Question: Express in one sentence what the figure is showing.
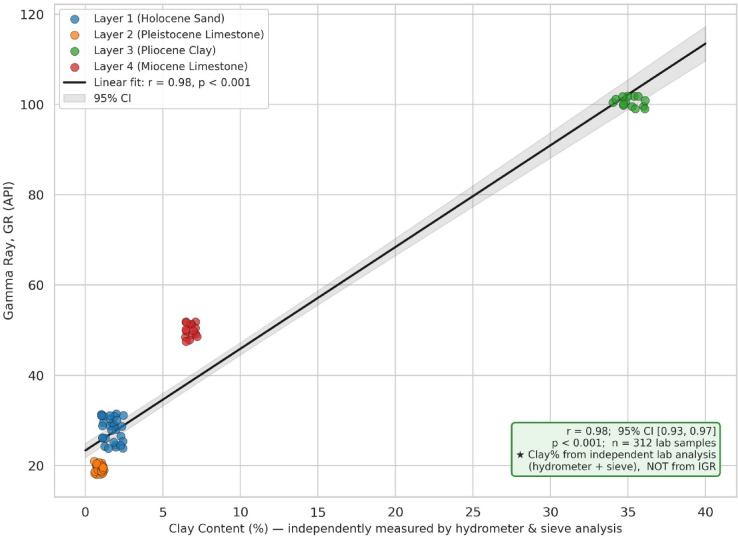
Answer: Relationship between natural gamma ray response (GR, API) and clay content (%) for all four geoelectrical layers ( n = 87 borehole–ERT stations; Ras El-Hekma). Clay content values on the x-axis were determined exclusively by independent laboratory granulometric analysis (hydrometer and sieve methods; n = 312 samples) and were not back-calculated from the gamma ray index (IGR); this independence confirms that the correlation is not tautological. Each data point is colour-coded by layer. The black line shows the ordinary least-squares regression fit across all data, with the 95% confidence interval shown as a grey-shaded band. The strong positive correlation ( r = 0.95; 95% CI: [0.93, 0.97]; p < 0.001) is particularly evident in Layer 3 (Pliocene Clay), where GR values exceed 99 API at clay contents of 34–36%. The regression forms the empirical basis for Eq. 4 (V_clay calibration), independently validated in Fig. 13 . Produced using Python (Https://matplotlib.org/; https://seaborn.pydata.org/tutorial/function_overview.html).